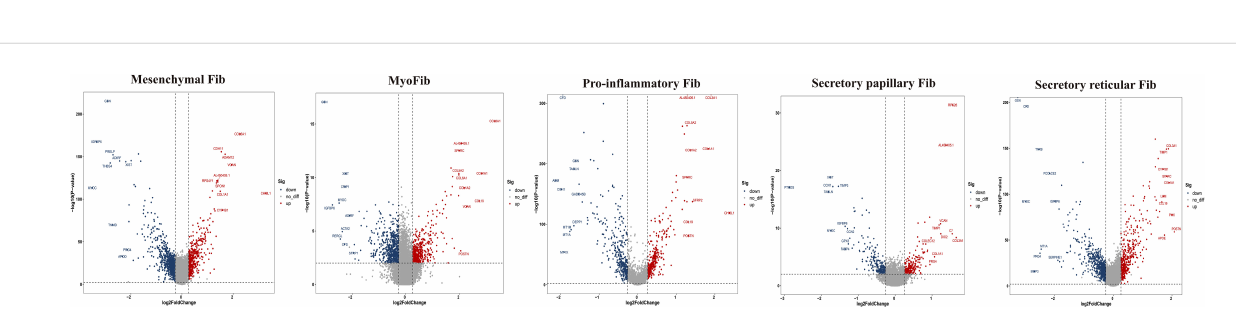
FIGURE 8 Top 10 differentially expressed genes (DEGs) of fi broblasts (Fib) subclusters in HG and NG. HG, high stress group; NG, normal stress